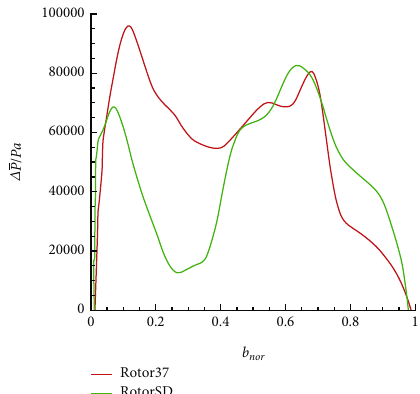
Figure 20: Schematic of parameter de fi nitions at the tip clearance.